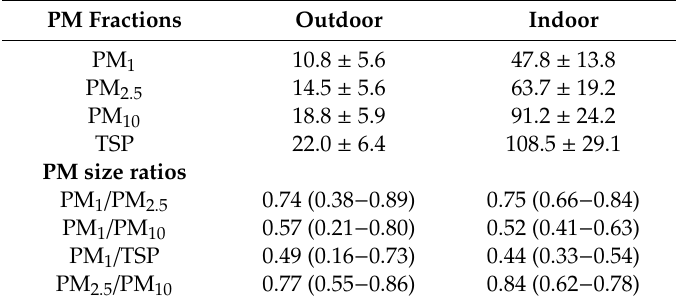
Table 3. Levels and ratios of PM fractions µ g / m 3 measured during non-heating periods in the outdoor air (outdoor samples) and in the preschools (indoor